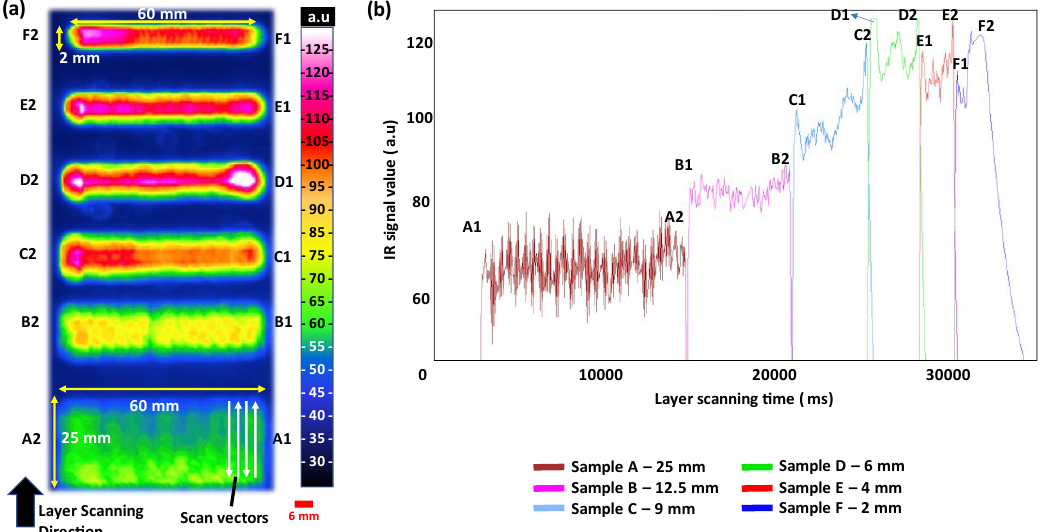
Figure 8. ( a ) Heat map representing the maximum value of each pixel of the thermal image in the selected region of interest. The rectangular cross-sections with fixed length (60 mm) and varying widths (25 mm, 12.5 mm, 4 mm and 2 mm) were scanned sequentially by the laser in a single layer. ( b ) IR-signal-time-plots with different line colours indicating the samples with varying widths. The data are clipped at 130 a.u. because of the limitation of the blackbody calibration range chosen. The time stamp starts at the beginning of capturing the signal ( t = 0) and not at the beginning of laser scanning.